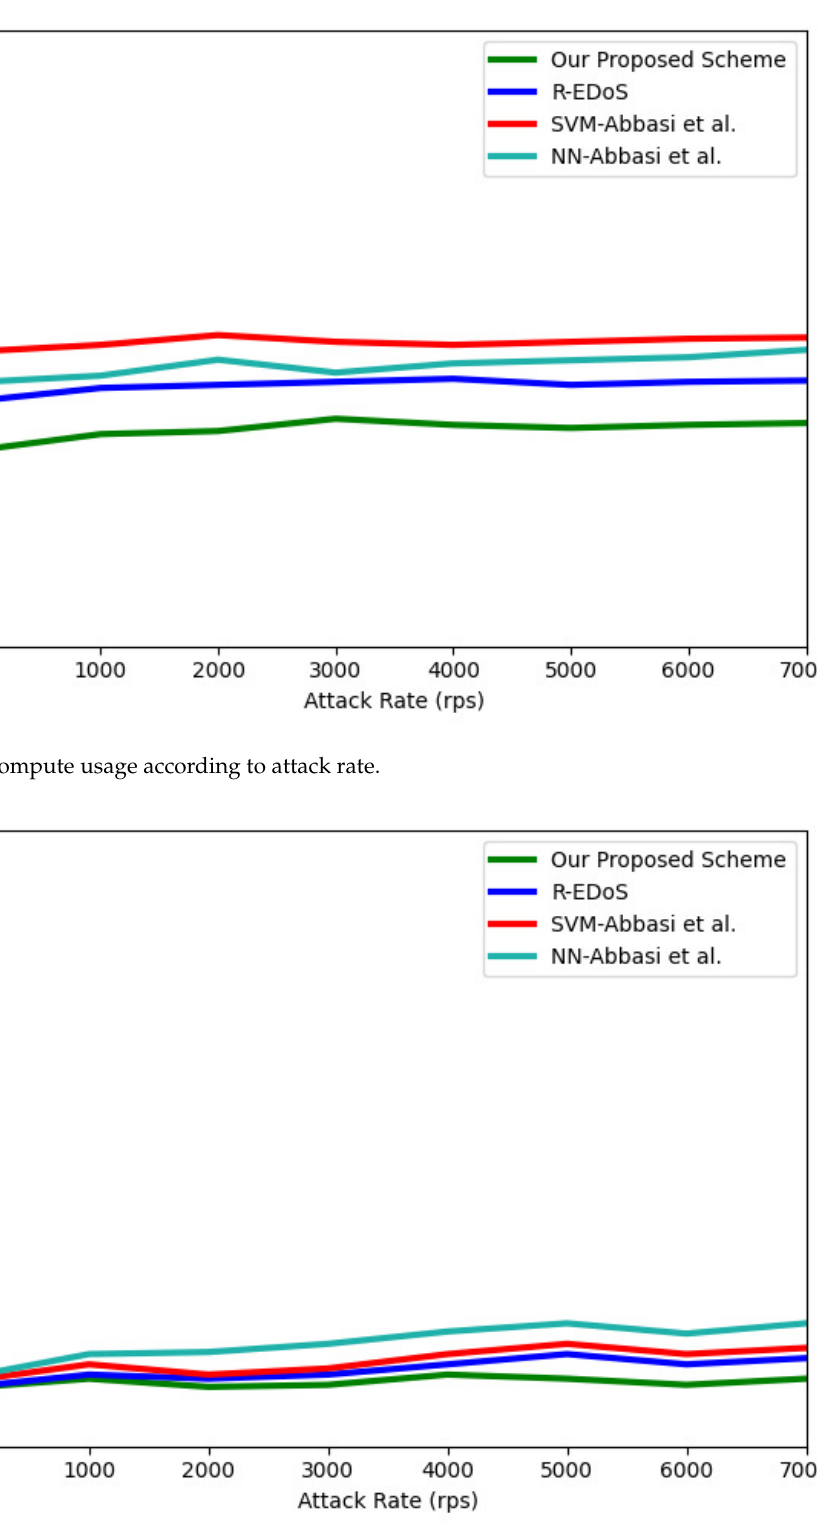
Figure 13. Memory usage according to attack